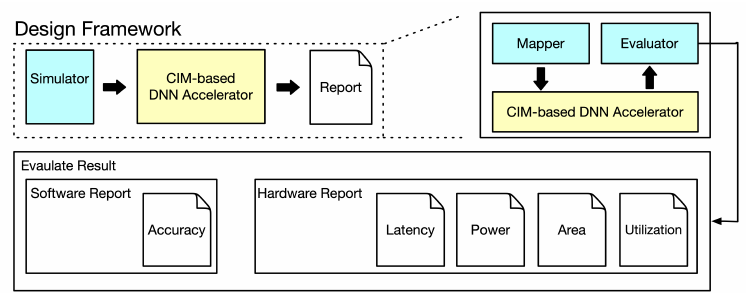
Figure 10. XBar architecture and ReRAM array